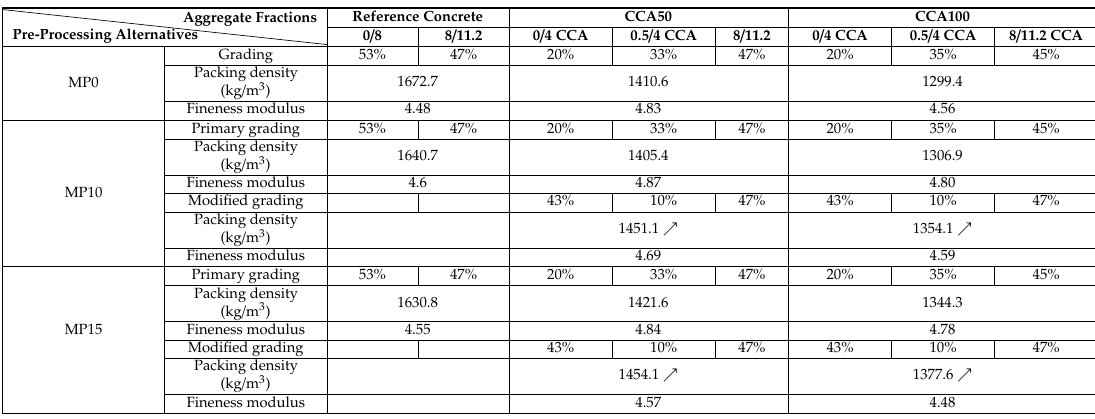
Table 4. Packing density and grading of concrete mixes.